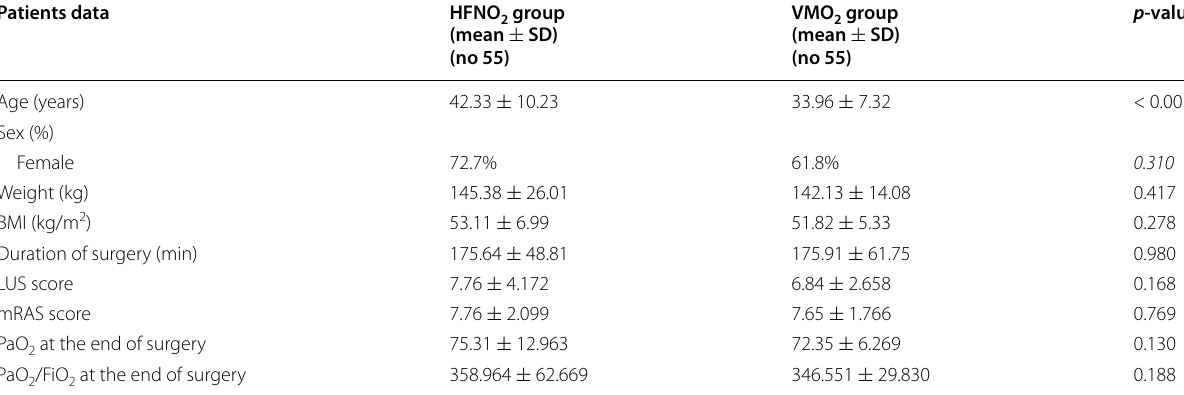
SD or frequency (%) as appropriate ±